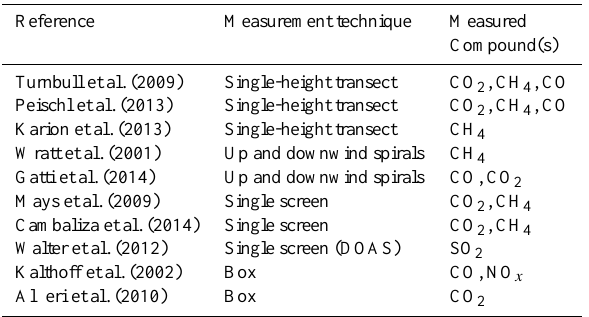
Table 1. Reported studies of ground-source emission estimations from aircraft-based